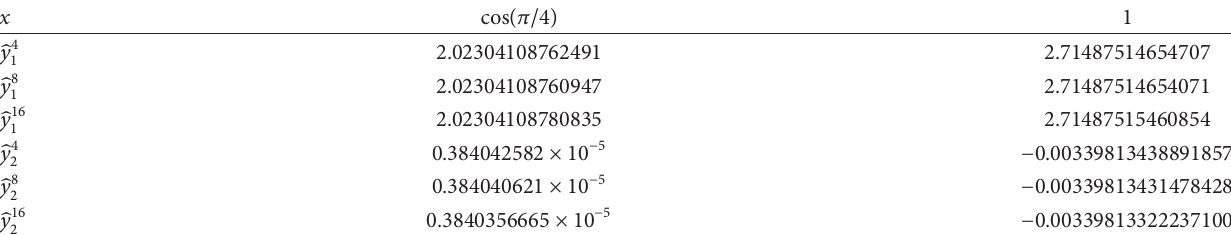
1 (𝑒 𝑖𝜔(𝑥−𝑡) /|𝑥 − 𝑡| 0.5 )𝑦(𝑡)𝑑𝑡 = 𝑒 𝑥 with 𝜔 = 10 6 −1